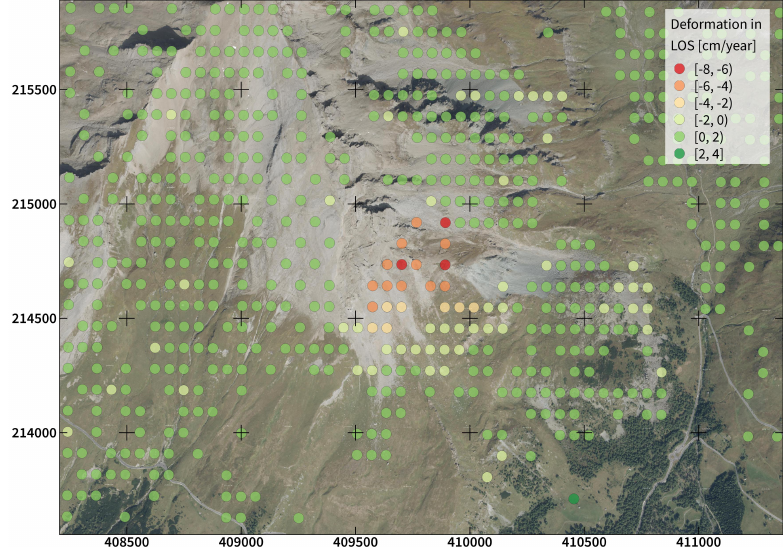
Figure 7. Deformation values of Racherin-Wasserradkopf ridge derived from P-SBAS, relative orbit 117. High deformation values indicate processes within the Guttal landslide. CRS, MGI/Austria GK M31